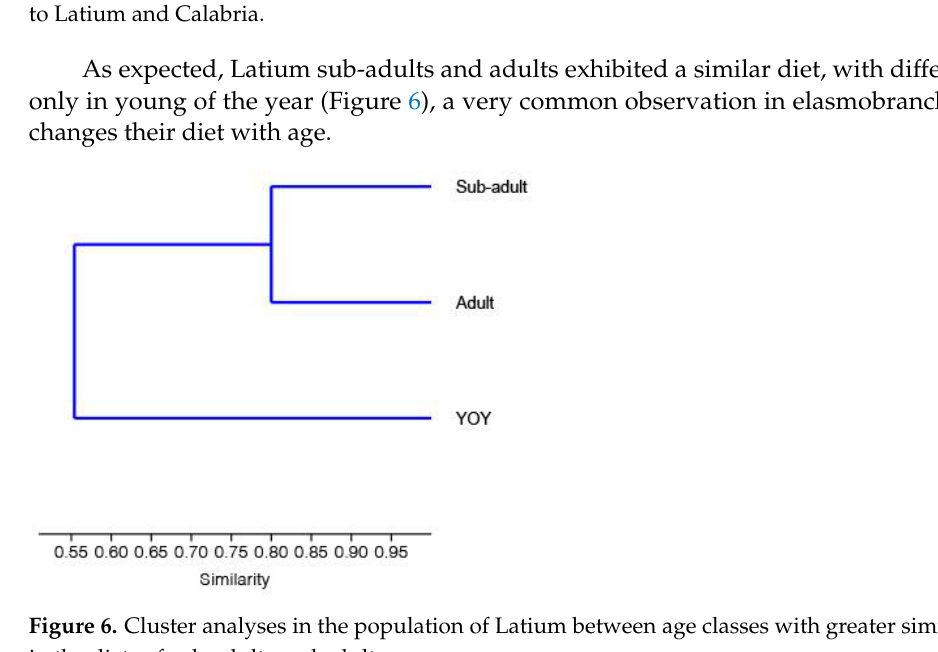
similarity between the populations of Tuscany (TU) and Liguria (LI). The acronyms LA and CT refer